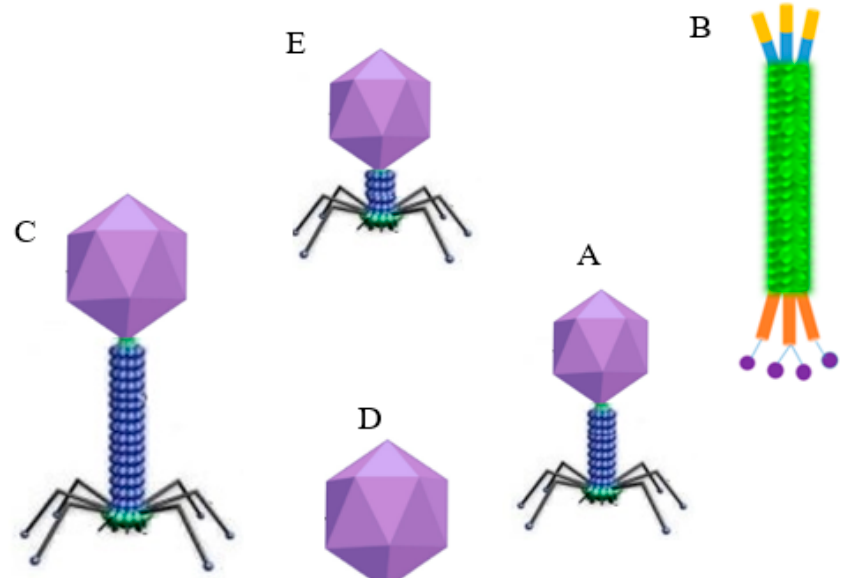
Figure 1. Schematic diagram showing the structure of major phage families: ( A ) Myoviridae (e.g., T4); ( B ) filamentous Inoviridae (e.g., M13); ( C ) long and noncontractile Siphoviridae (e.g., λ phage); ( D ) Leviviridae ; and ( E ) short Podoviridae (e.g., T7).